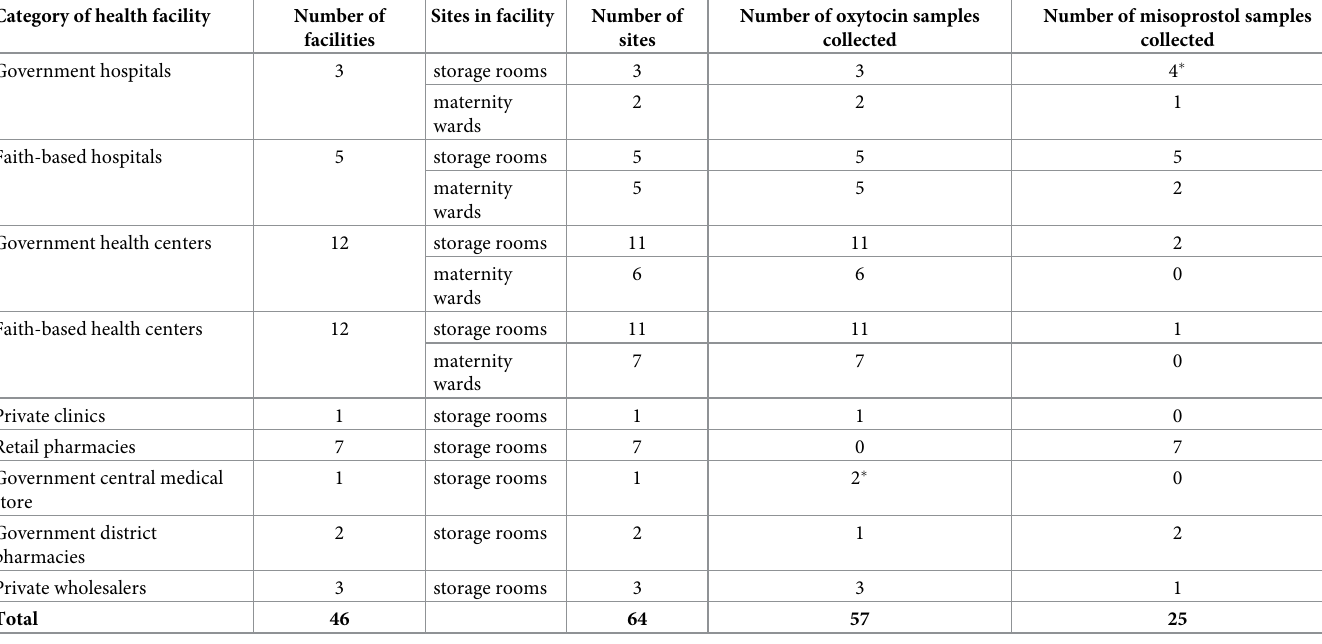
Table 1. Overview of sampling sites for oxytocin injections and misoprostol tablets.